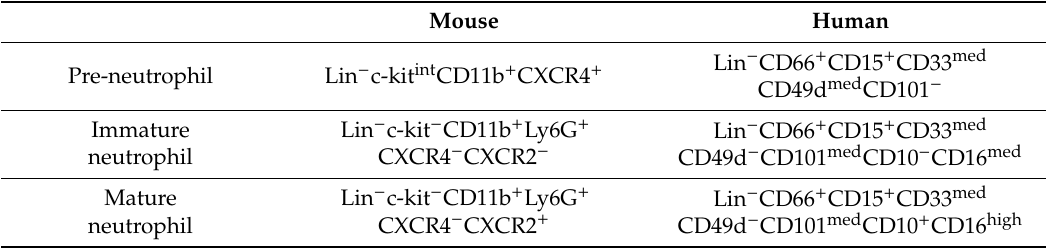
Table 1. Surface markers of mouse and human preneutrophils, immature neutrophils and mature neutrophils. Lin, lineage